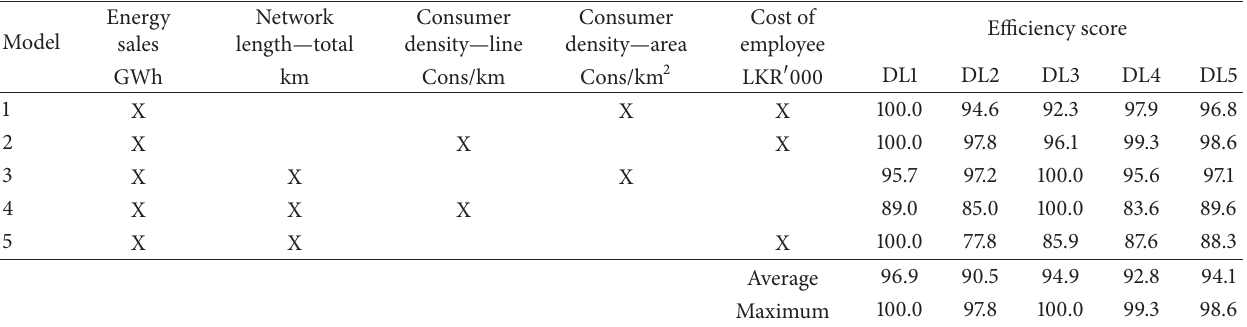
Table 7: COLS with four variables.